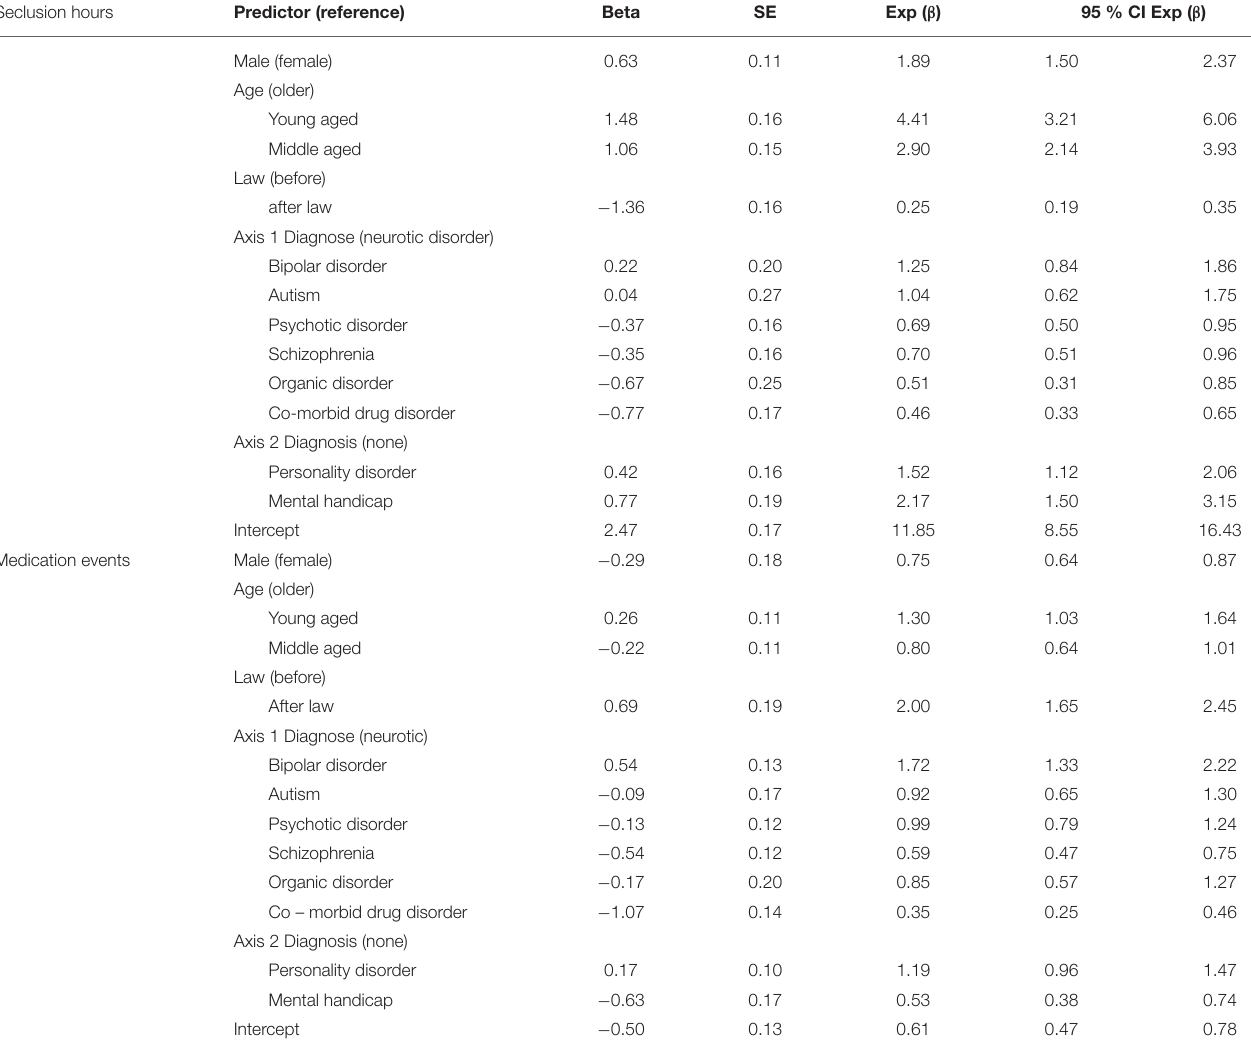
TABLE 3 | Generalized linear models with negative binomial link findings. Seclusion